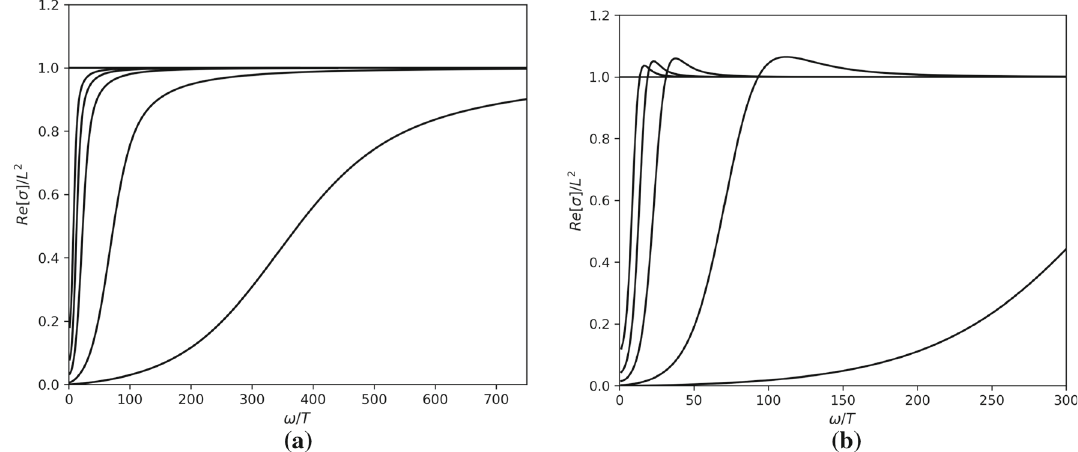
Fig. 8 The evolutions of Re σ (ω) versus ω/ T at ε = 16 π, L = 0 . 5 for O 1 ( a ) and O 2 ( b ). Each graph, from left to right, is plotted for the cases T / T c = 0.7, 0.5, 0.3, 0.1 and 0.02 respectively